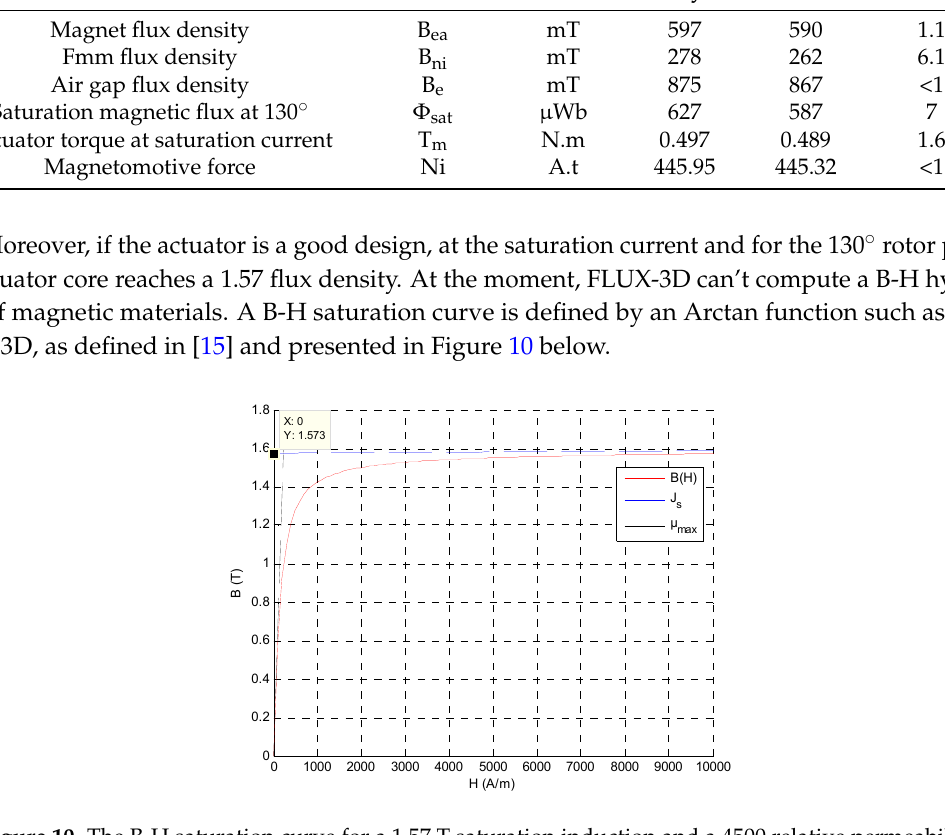
Figure 10. The B-H saturation curve for a 1.57 T saturation induction and a 4500 relative permeability.